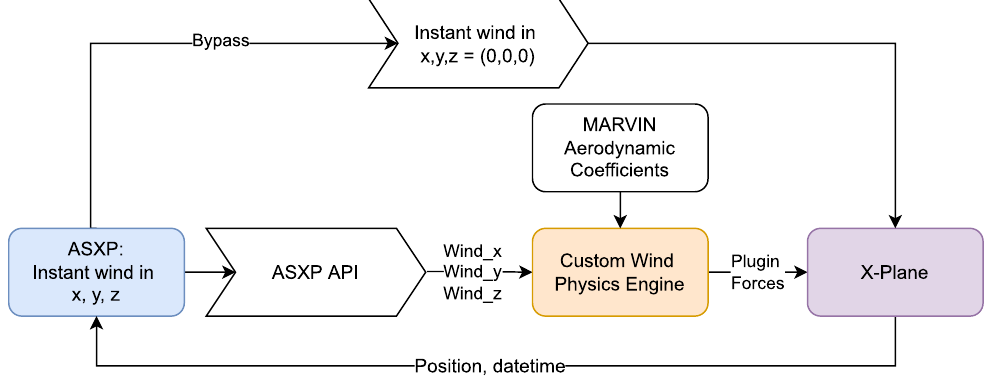
Figure 5. Weather and physics subsystem integration scheme. The Custom X-Plane Ground Effect Plugin has been omitted from this diagram since it will be explained in the following subsection.